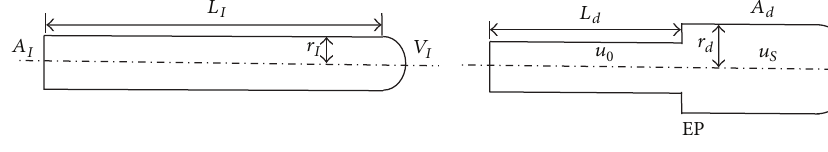
Figure 8: The deformed projectile.